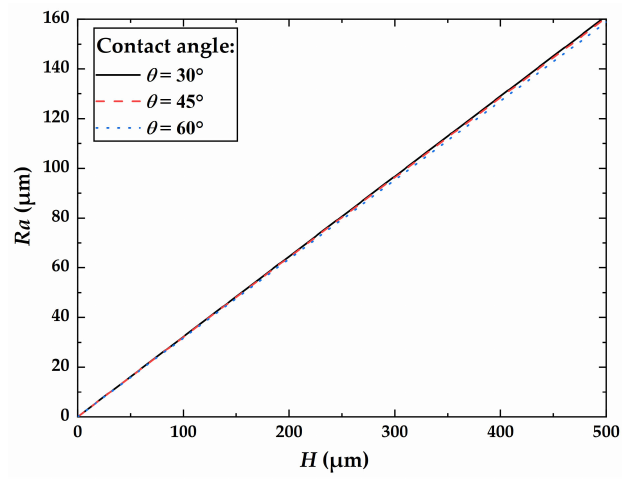
Figure 2. Variation in roughness with bead height at different contact